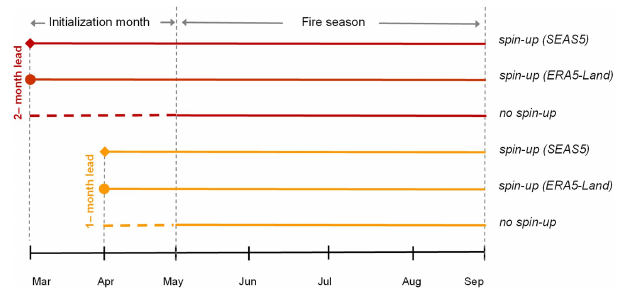
Figure 1. Experimental setups used for FWI calculations. Fore- casts are initialized in April (1-month lead time, in yellow) and March (2-month lead time, in red), while three different experi- ments concerning the spin-up period (a) with no spin-up (dashed line), (b) with spin-up implanting the ERA5-Land data (solid line– circle symbol) and (c) with spin-up using the SEAS5 model data (solid line–diamond symbol) are